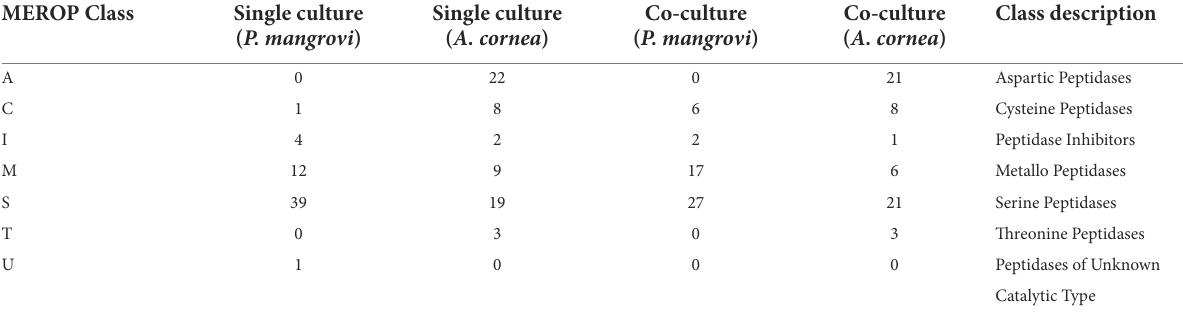
TABLE 4 Number of transporters identified with TCDB. TCDB Class Single culture ( P. mangrovi